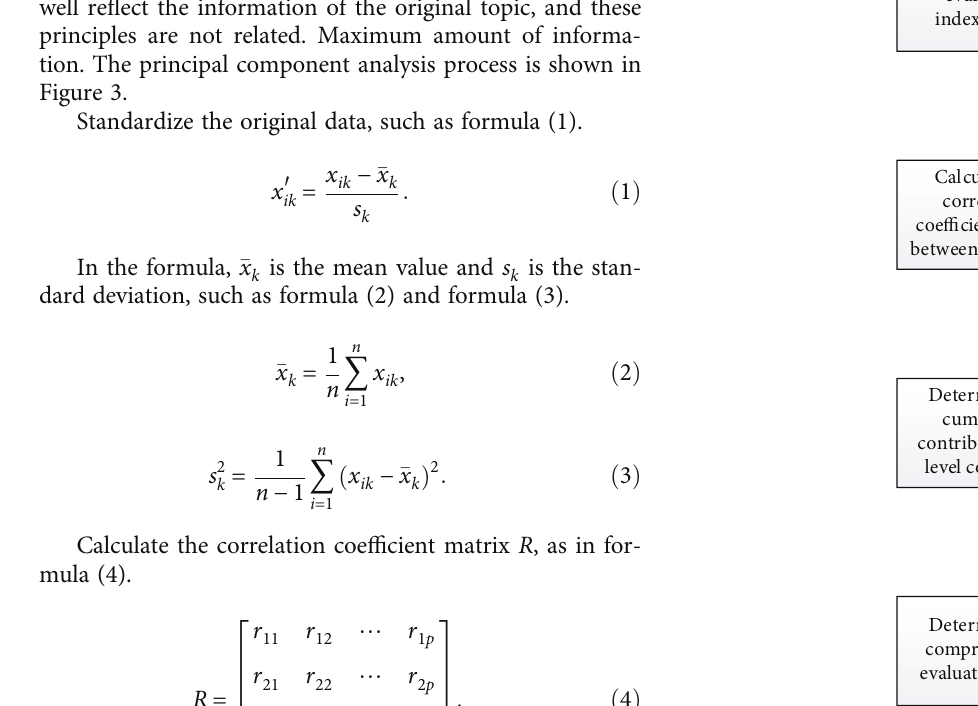
Figure 3: Flowchart of principal component